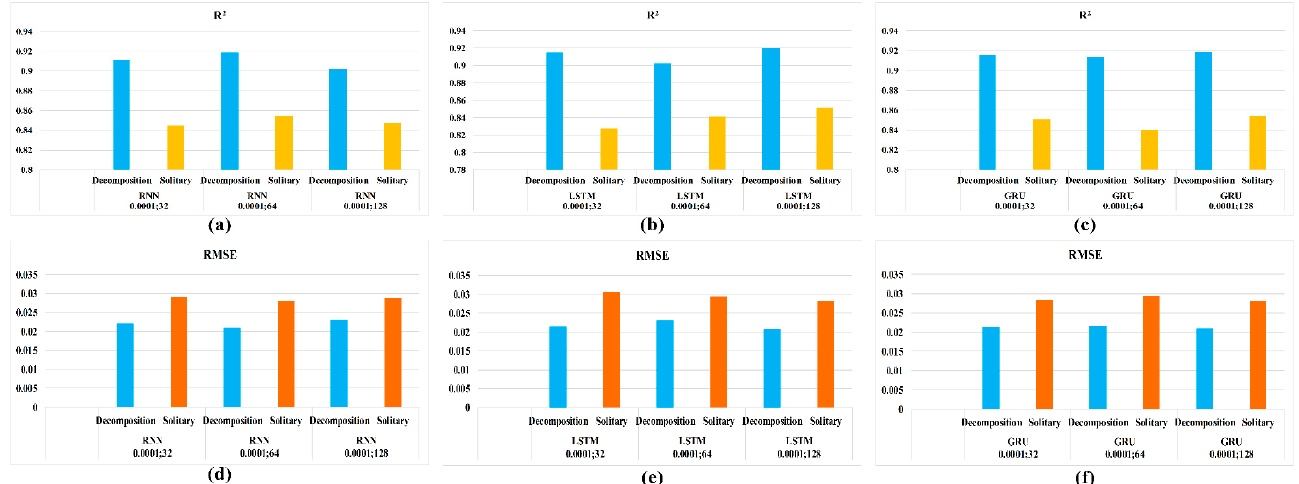
Figure 10. Determination coefficients and RMSE losses with the two prediction methods for the three RNN-based models. ( a – c ) and ( d – f ) are the coefficient of determination and RMSE loss under the same parameters of the model.